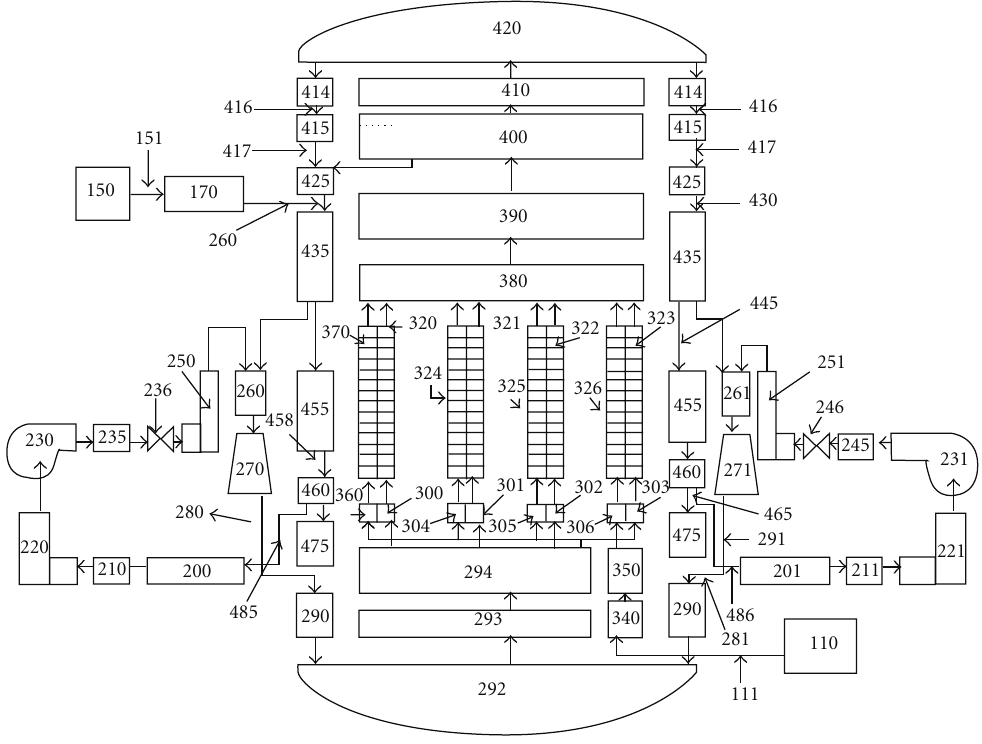
Figure 20: Representative RCS nodalization for